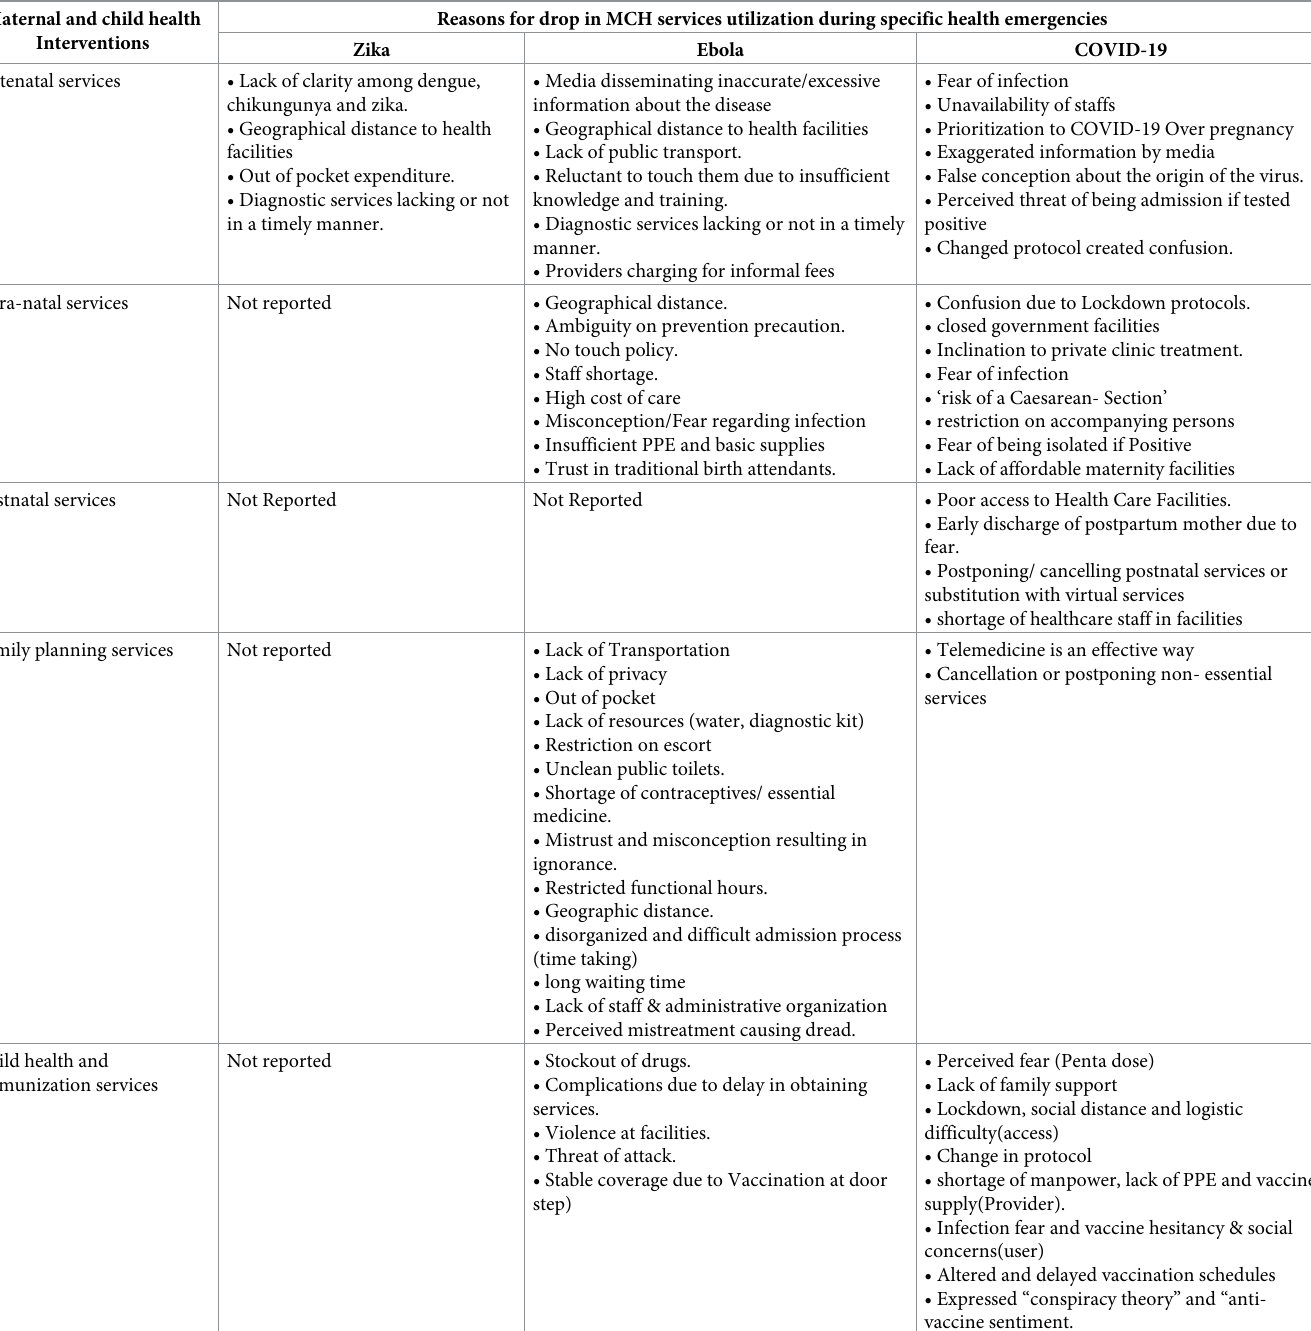
Table 1. Qualitative finding